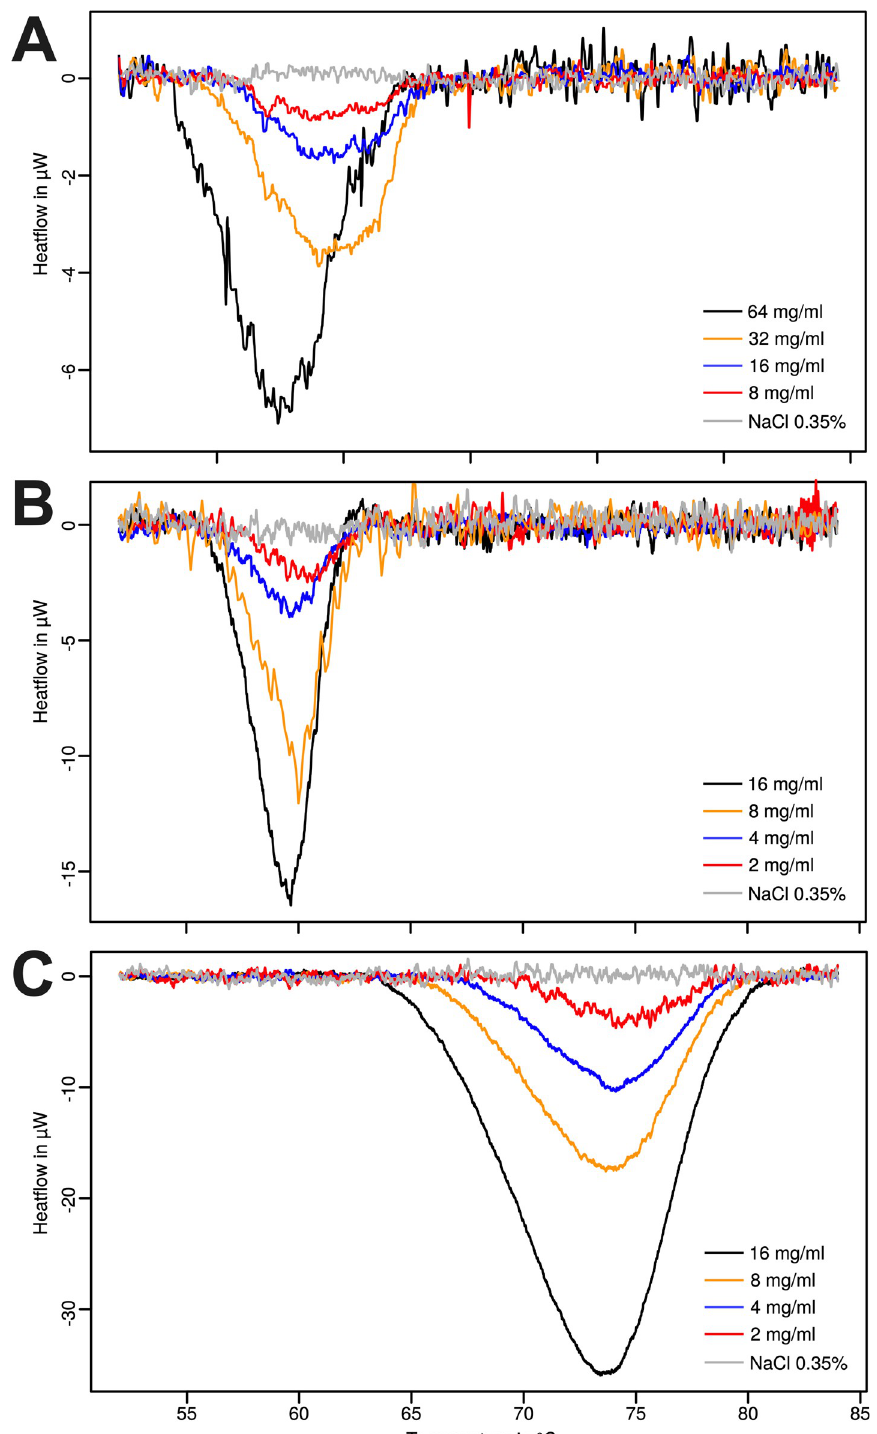
Fig 2. DSC pattern of increasing concentrations of protein measured in the TAM 48: (A) Mucin, (B) bovine serum albumin, (C) lysozyme. Peak value and enthalpy measured can be found in Table 2.